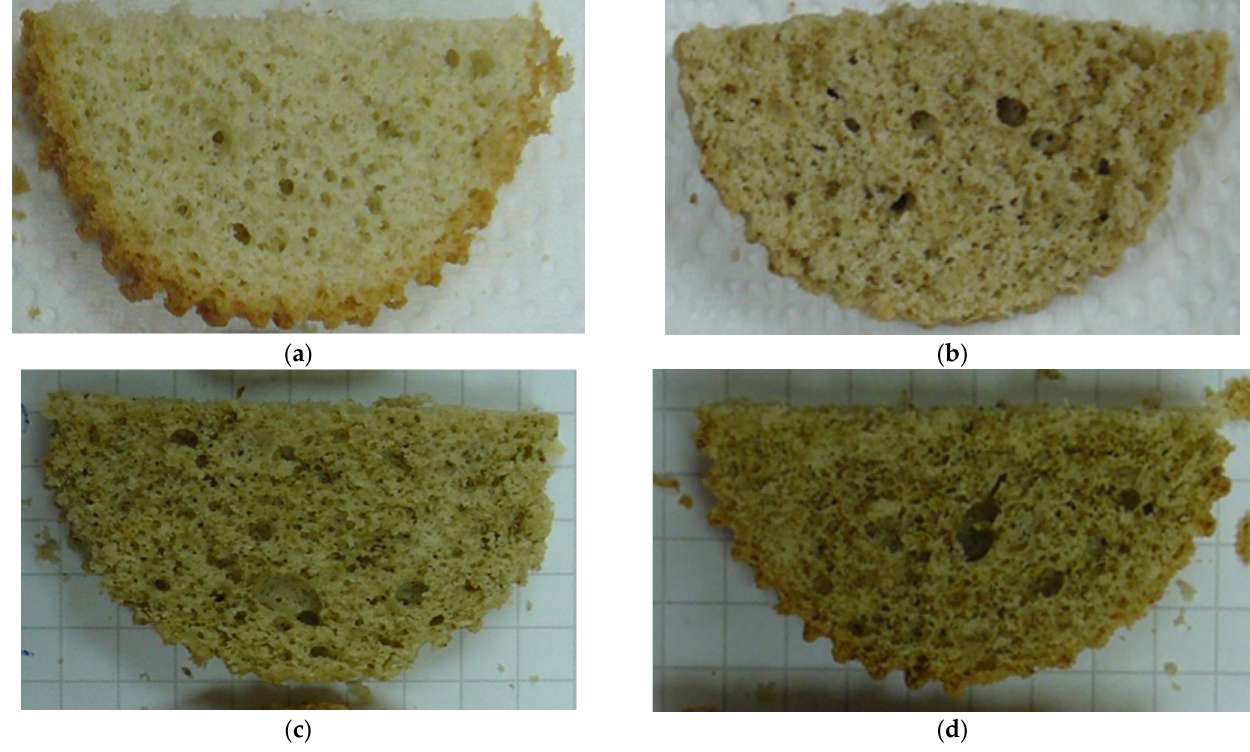
Figure 5. Photo of investigated sponge cakes in the crumb. ( a ) Crumb of Control sample. ( b ) Crumb of Option 1. ( c ) Crumb of Option 2. ( d ) Crumb of Option 3.